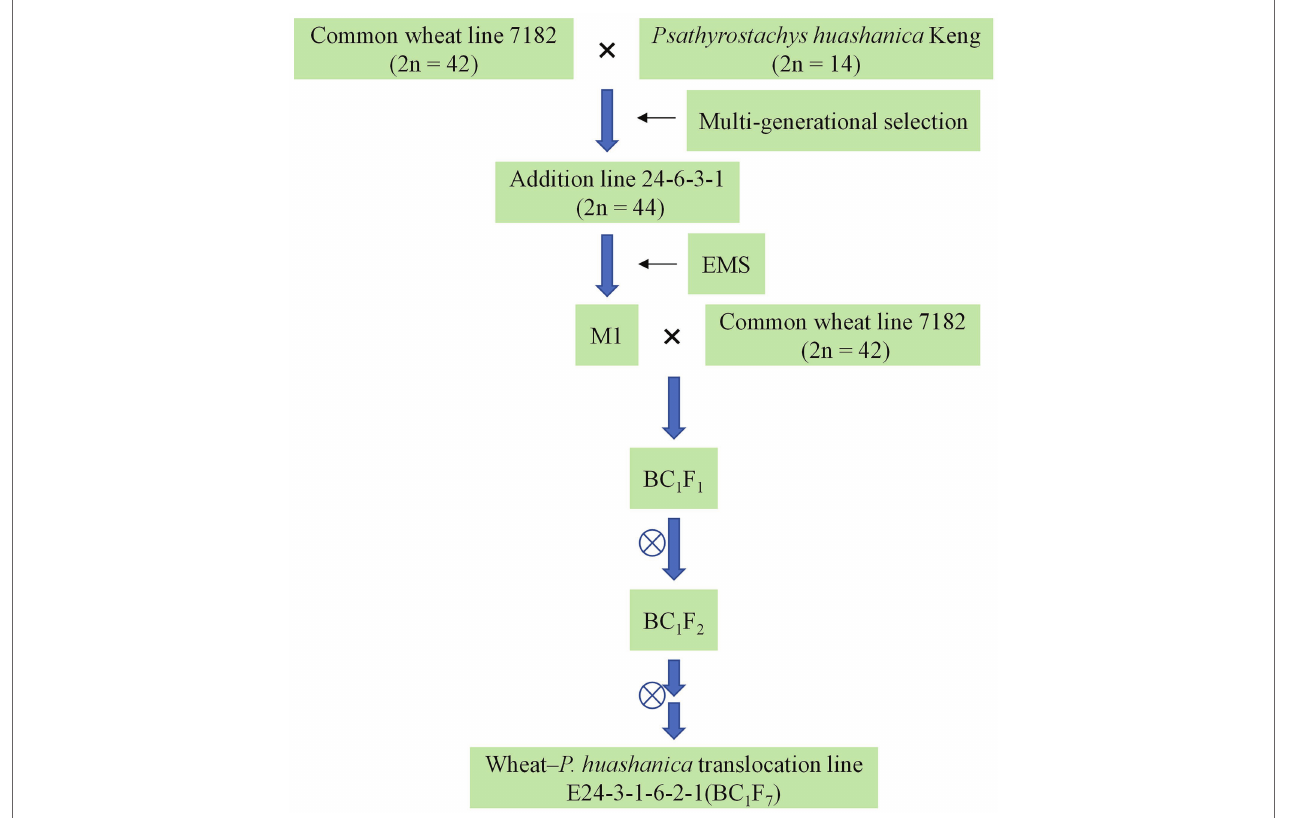
FIGURE 1 | Scheme of the development of wheat– Psathyrostachys huashanica translocation line E24-3-1-6-2-1.